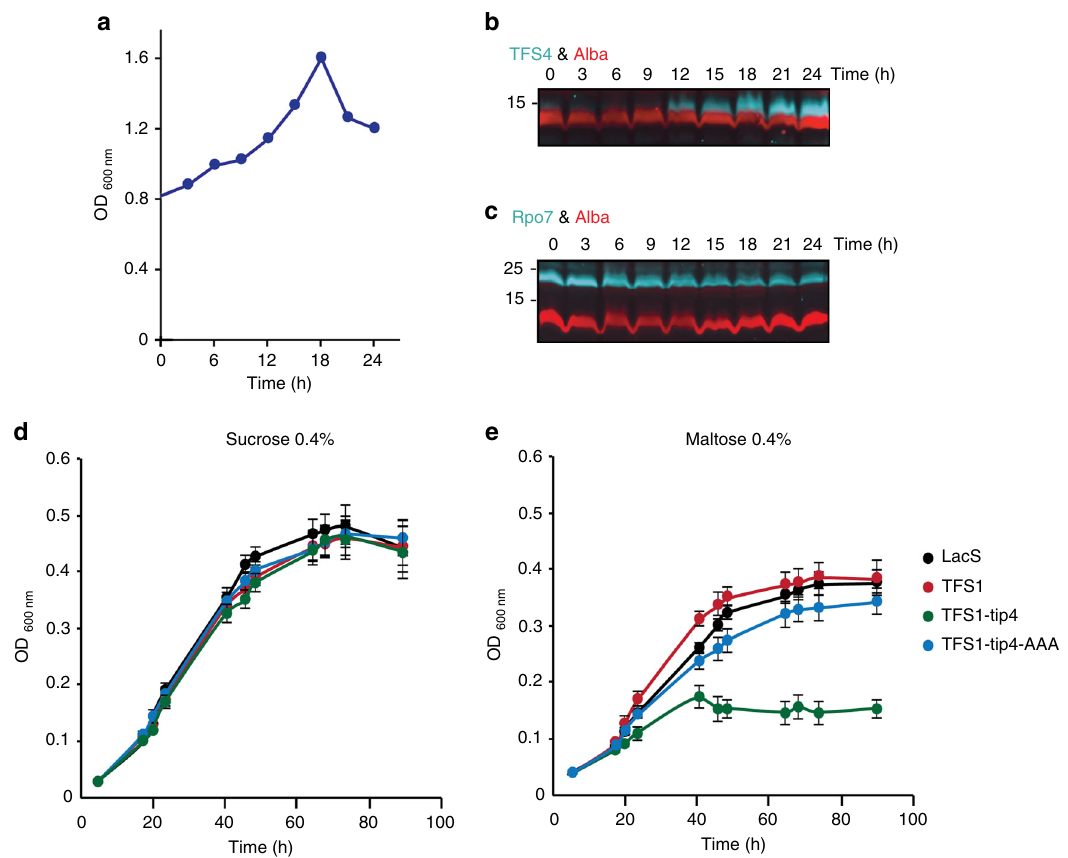
Fig. 6 STIV virus infection induces TFS4 expression levels and growth retardation. a Infection time course experiment. The growth curve shows the increase of the optical density of S. solfataricus (strain 2-2-12) following infection by the STIV virus ( t = 0). b, c Multiplex Western blot using polyclonal antibodies raised against TFS4 ( b ), RNAP subunits Rpo4/7 ( c ) and Alba (loading control) as a function of time following infection by STIV. Immunodetection was performed on two biological replicates. d Growth curves of S. acidocaldarius MW001 harbouring expression vectors encoding TFS1, TFS1-tip4, TFS1-tip4-AAA and LacS (control) under non-inducing or inducing e conditions using sucrose or maltose containing media, respectively. Error bars represent standard deviation from three technical